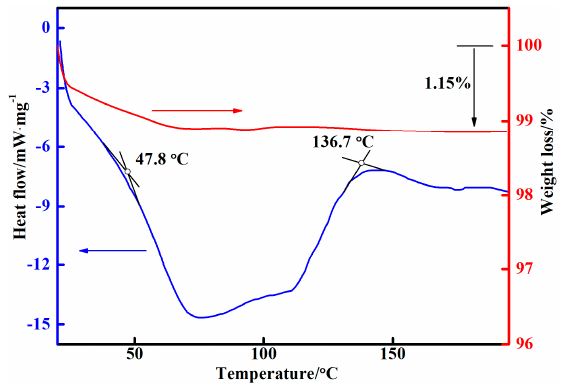
Figure 2. DSC and TG curve of the inorganic phosphate adhesive.